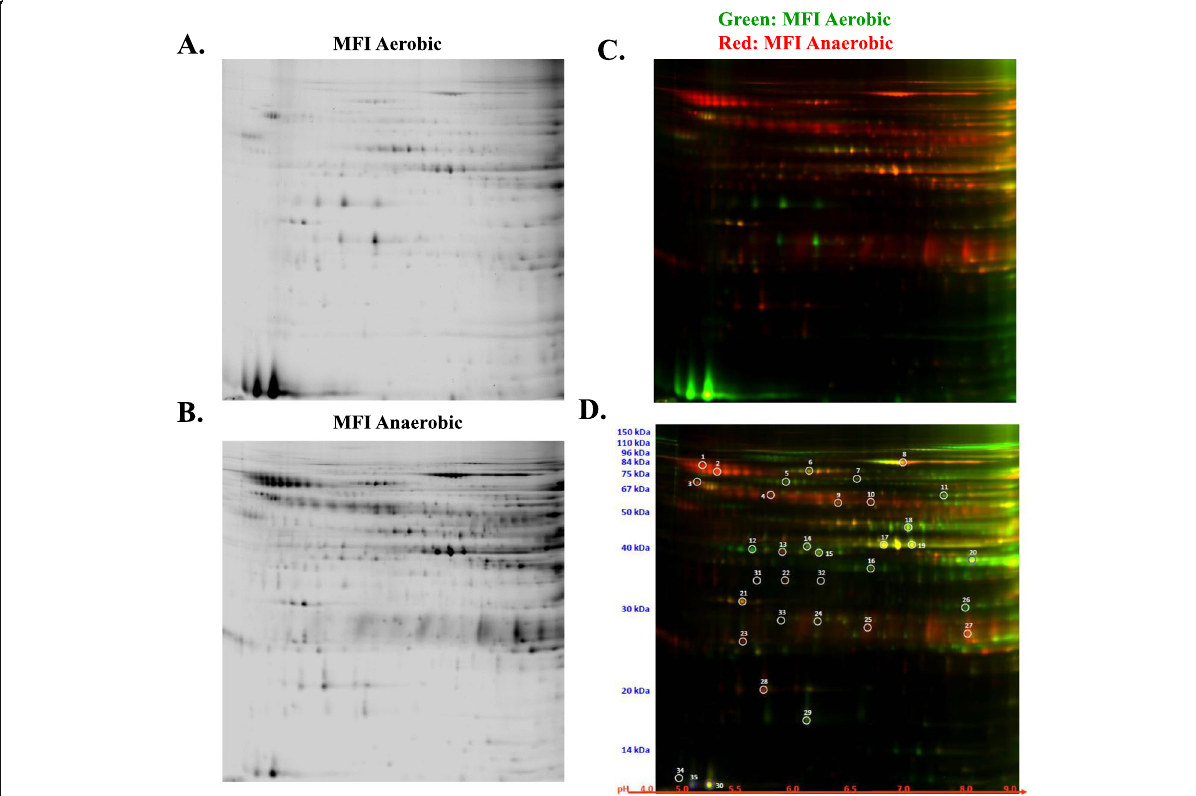
Fig. 1 a : 2D-Dige Triton X-114 liposoluble fractions of Mycoplasma fermentans MFI, grown in aerobic and b : anaerobic conditions. c : Superimposition of the signals generated by 2D-Dige Triton X-114 liposoluble fractions of MFI. Growing conditions are indicated in figure with red, anaerobic, and green, aerobic. d : 2D-Dige gel map of MFI liposoluble proteins showing the protein identification number obtained